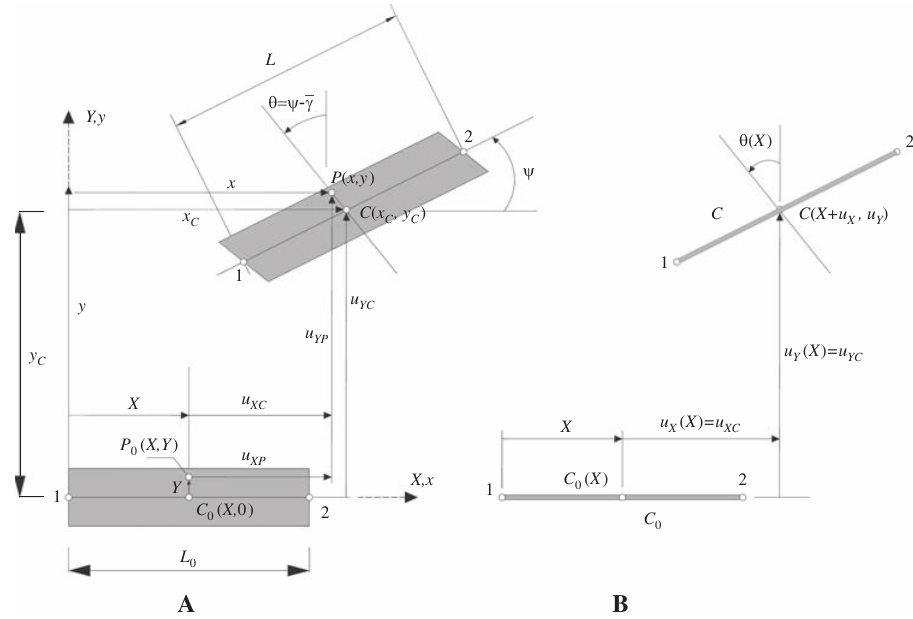
Figure 4 Lagrangian kinematics of the C 0 beam element with X -aligned reference confi guration: (A) plane beam moving as a two-dimen- sional body; (B) reduction of motion description to one dimension measured by coordinate X [41]